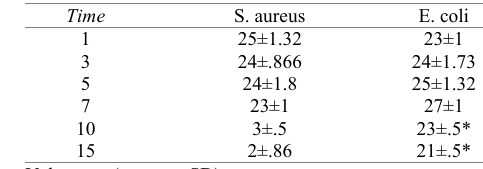
Table 1: Antimicrobial activity of CFX@PVA silk sutures